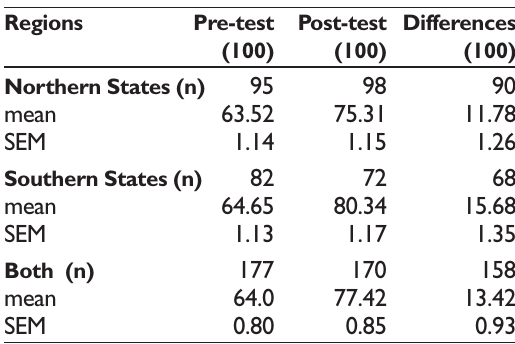
Pre-test, Post-test and Differences between the